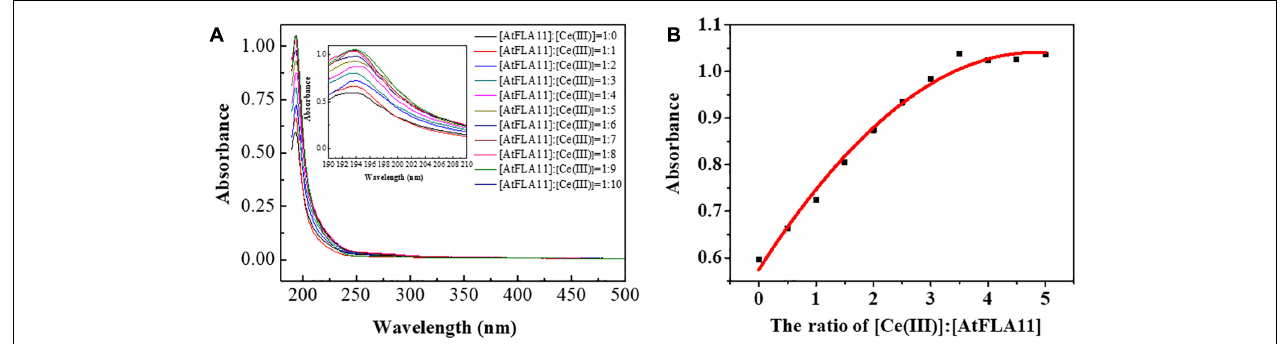
FIGURE 8 | The UV-vis spectra of 5.00 × 10 − 7 M AtFLA11 containing Ce(III) at different concentrations (A) and the fitted curve of the absorbance near 194 nm (B) . The measurements were carried out 12 h after incubating AtFLA11 with Ce(III).